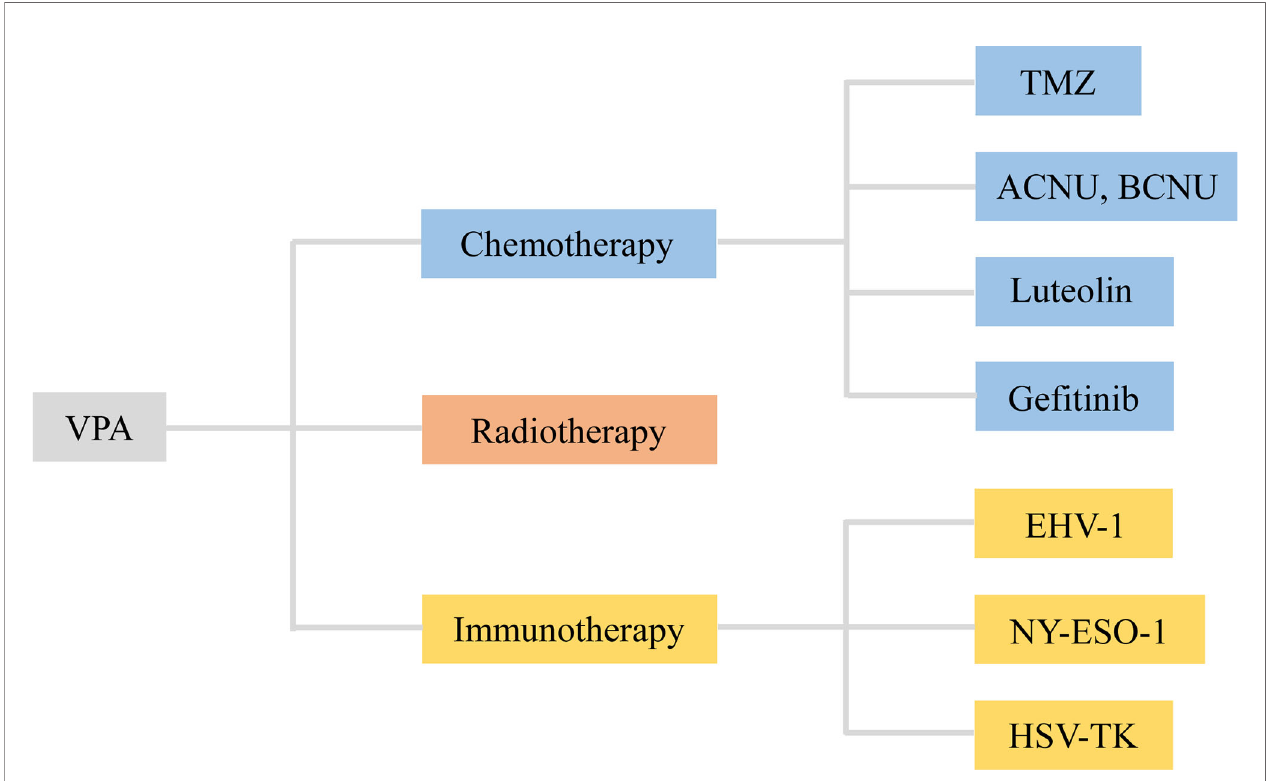
FIGURE 3 | VPA served as an adjuvant agent in chemotherapy, radiotherapy, and immunotherapy of glioma. VPA, valproic acid; ACNU, nimustine; BCNU, 1, 3-bis (2-chloroethyl)-1-nitrosourea; EHV-1, equine herpesvirus type 1; HSV-TK, herpes simplex virus type I thymidine